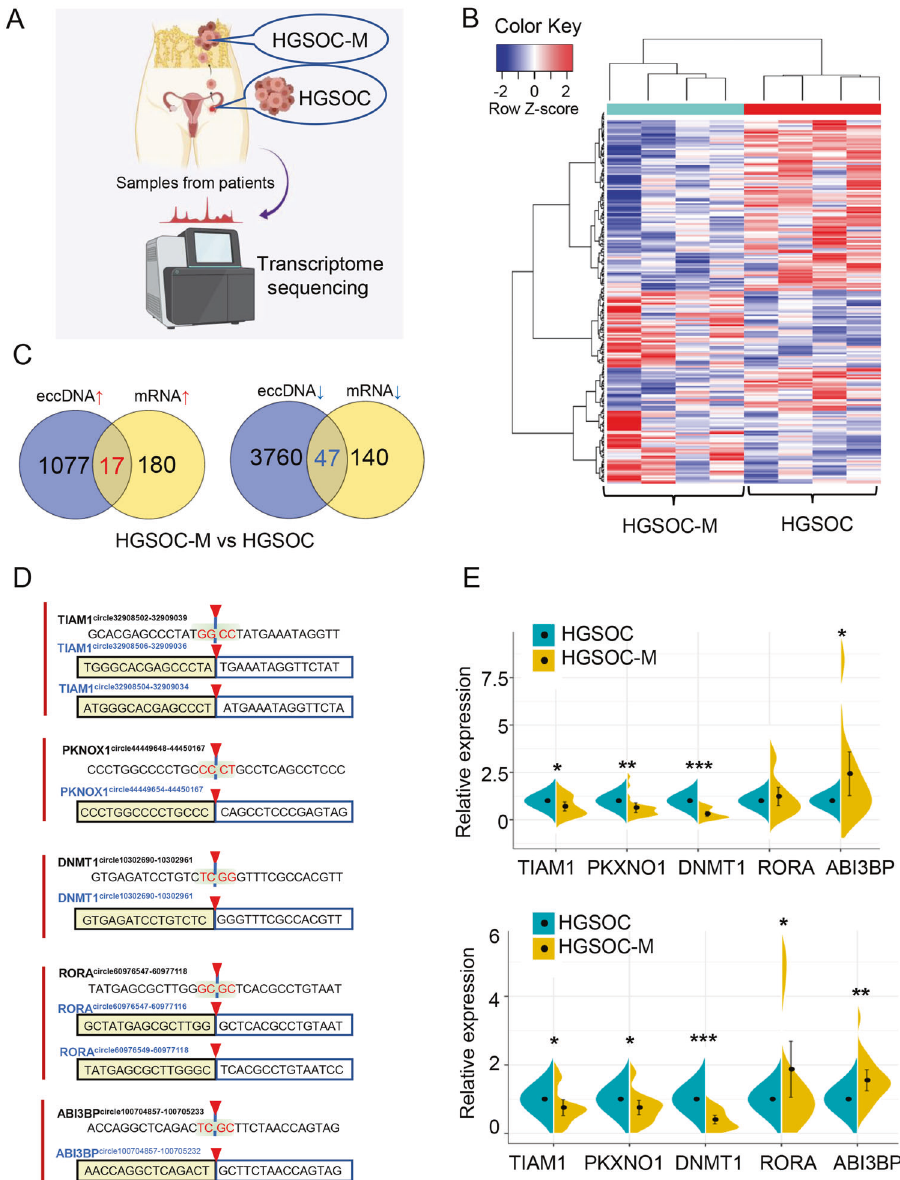
Fig. 4 Validations of the differentially expressed eccDNAs in primary and metastatic tissues of HGSOC samples. A Flowchart illustrating the transcriptome analysis of paired primary and metastatic tissues of HGSOC (HGSOC 1-4 and HGSOC-M 1-4). B Clustered heatmap of differentially expressed mRNA in paired primary and metastatic tissues of four HGSOC patients. Red, up-regulation; Blue, down-regulation. C Venn diagrams showing the overlap of all differentially expressed mRNAs and eccDNAs of the same host gene. Left, up-regulated targets in both sequencing; Right, down-regulated targets in both sequencing. D Sanger sequencing results of PCR products of 15 bases on either side of junctions of eccDNAs derived from TIAM1, PKNOX1, DNMT1, ABI3BP and RORA,were listed in boxes, respectively. Black (upper) indicated the junction sequences of each eccDNA by Circle-Seq, with shaded (red) sequences depicting junction sites. Blue (lower) indicated the accurate circularization sites of each eccDNA based on Sanger sequencing results. E qPCR validations of 5 differentially expressed mRNAs (upper panel), and differentially expressed eccDNAs (lower panel) in 20 clinical HGSOC tissue samples containing 20 primary tissue samples (blue, HGSOC) and paired metastatic tissue samples (yellow, HGSOC-M). The data of the expression levels were shown as mean ± SD. * P < 0.05, ** P < 0.01, *** P <